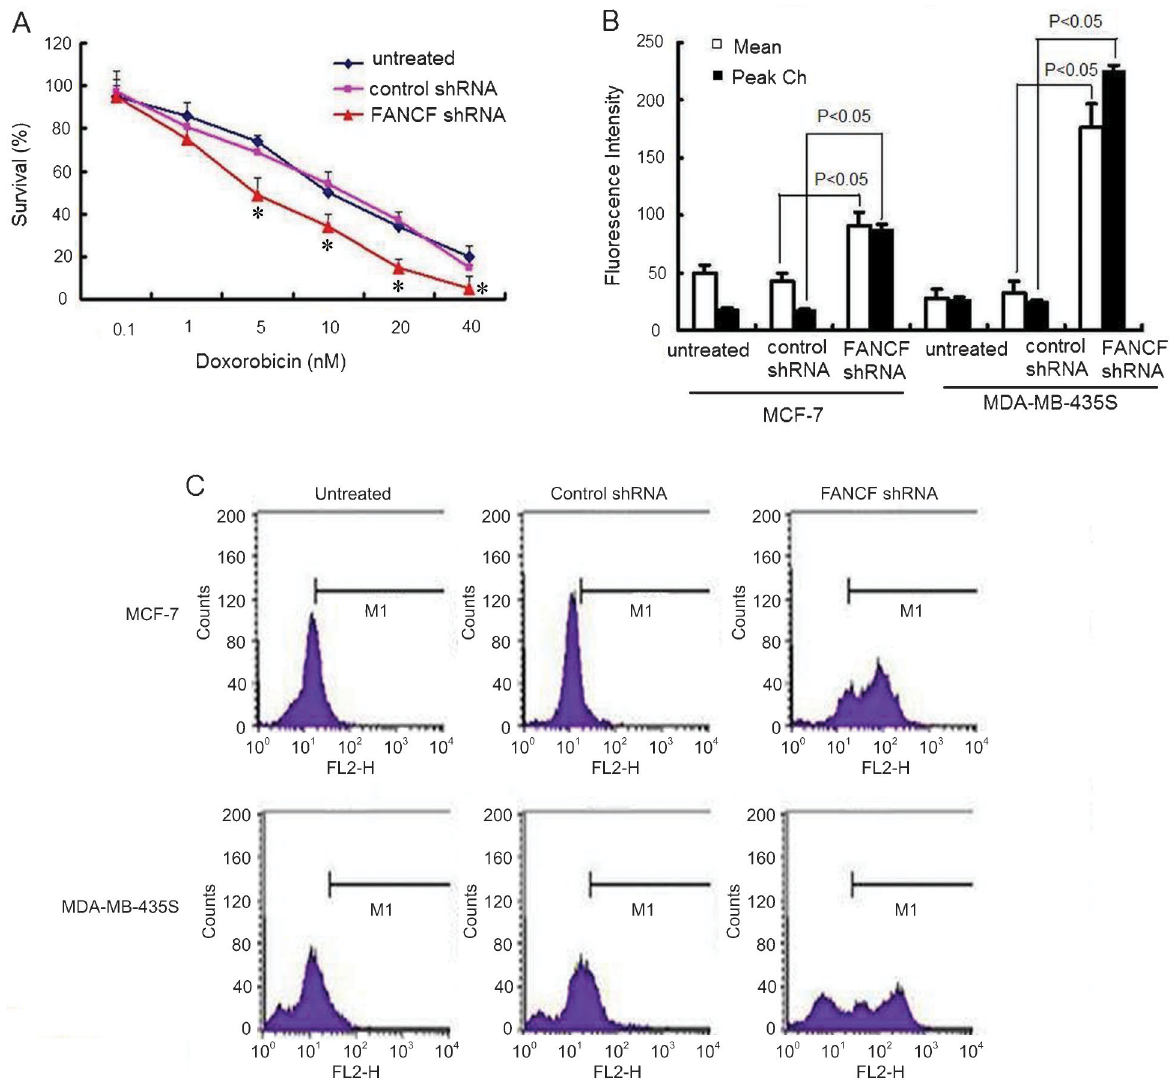
Figure 7. Effects of FANCF-specific shRNA on Dox sensitivity of MCF-7 and MDA-MB-435S cells. A , Cells were treated with various concentrations of Dox. Cell viability was determined with a CCK-8 kit. The percentage of viable cells was determined by the ratio of viable cells treated with FANCF shRNA or control shRNA to that with no treatment. B , Median fluorescence intensity was measured indicating the relative amount of Dox accumulation. C , Effects of FANCF shRNA on cellular Dox accumulation. Cells were transfected with FANCF shRNA or control shRNA for 48 h following a 24-h incubation with 10 nM Dox. Cellular uptake of Dox was measured by fluorescence-activated cell sorting. Data are reported as means±SD of three independent experiments in triplicate. *P , 0.05, ANOVA followed by the post hoc